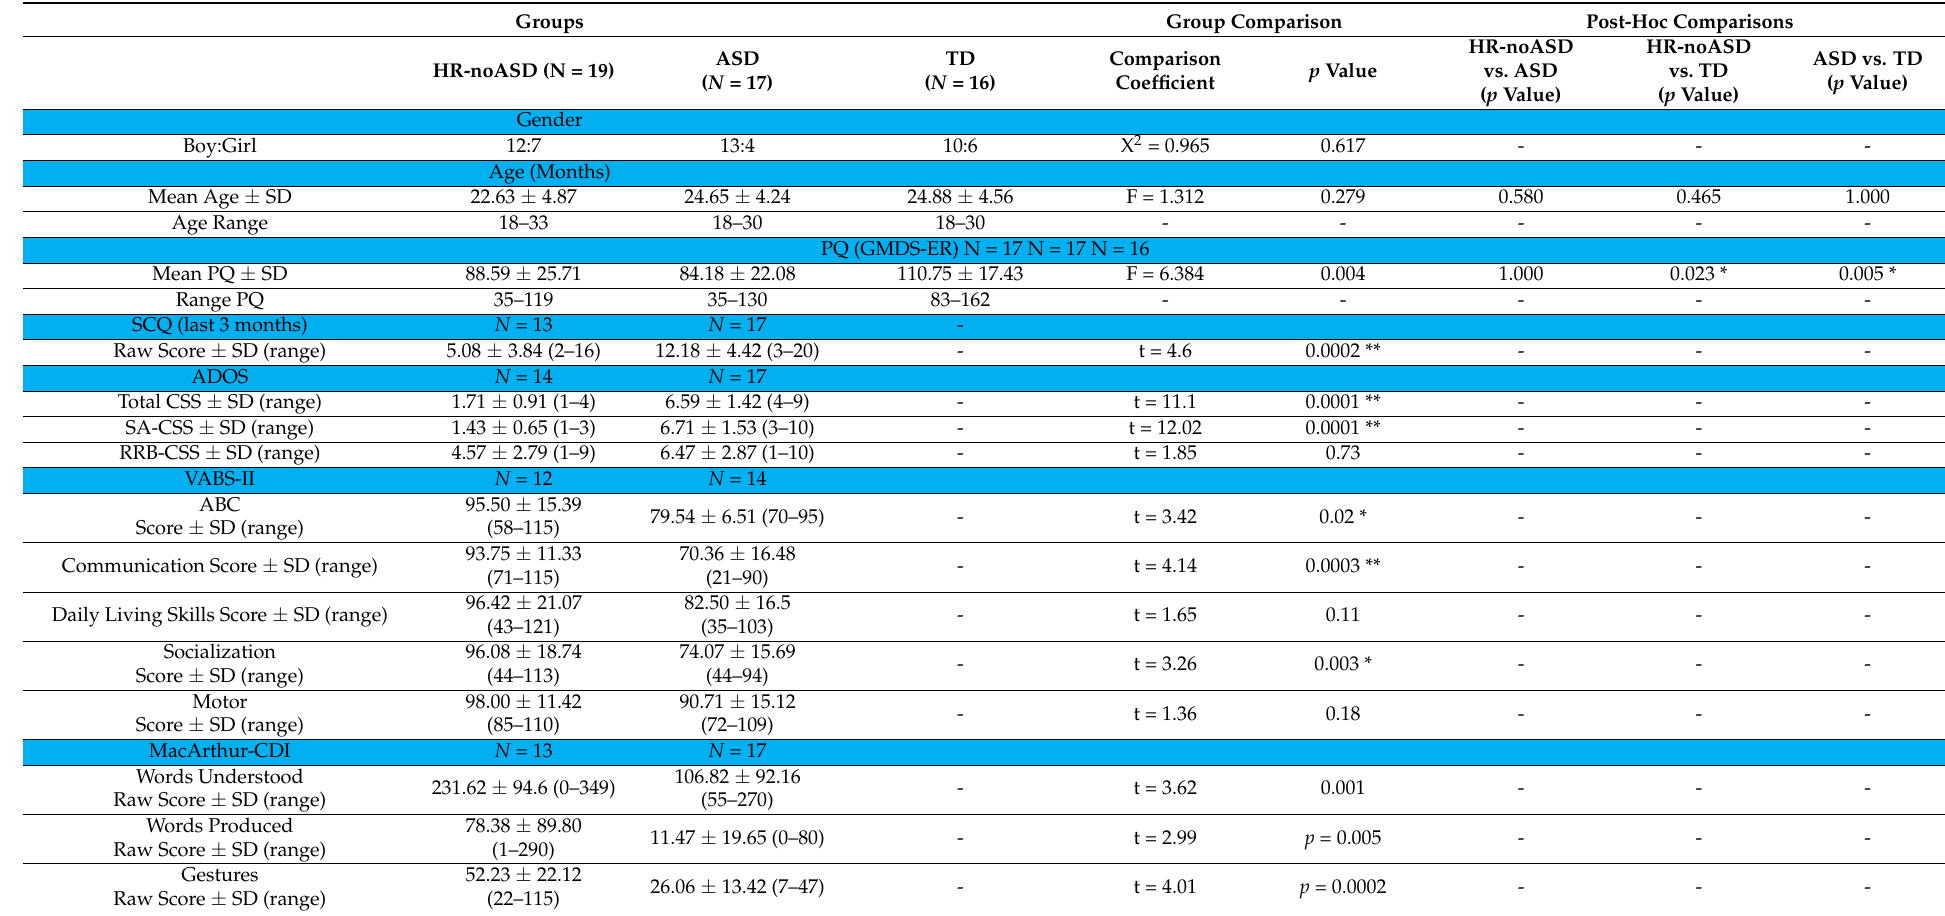
Table 1. Demographic and clinical characteristics of ASD, HR-noASD and TD groups.